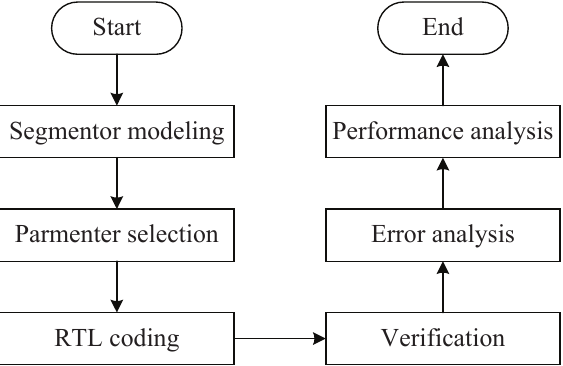
Figure 7. Flowchart of the proposed